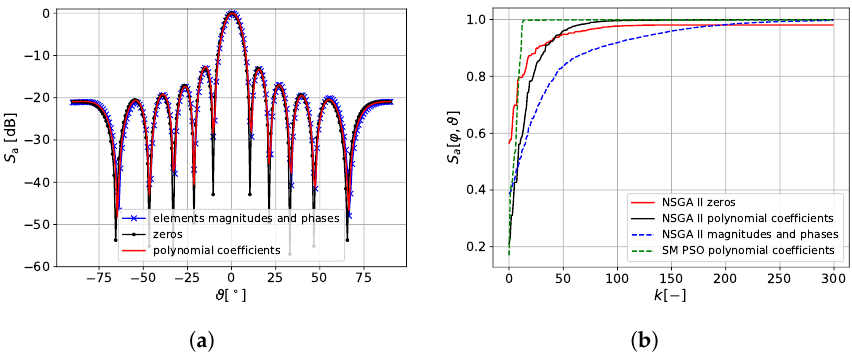
Figure 11. Convergence of algorithm with different parameter sets. ( a ) Array factor; ( b )